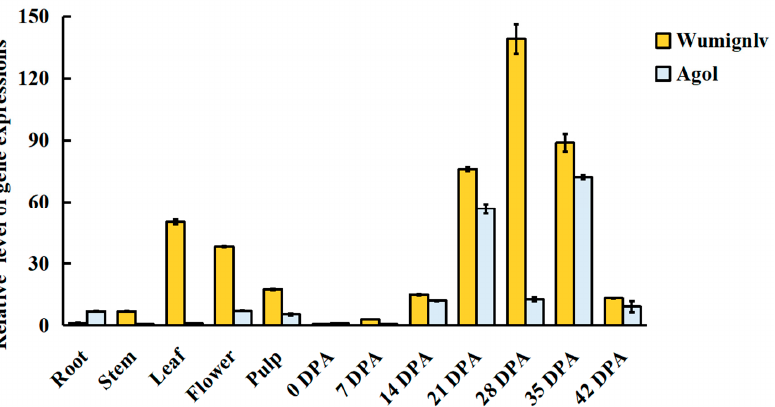
Figure 4. Transcript expression of CmaCh15G005270 in root, stem, leaf, flower, pulp, and different development stage of seed coat in Wuminglv and Agol. CmaCh15G005270 was highly expressed in leaf, flowers, pulp, and seed coat in Wuminglv.